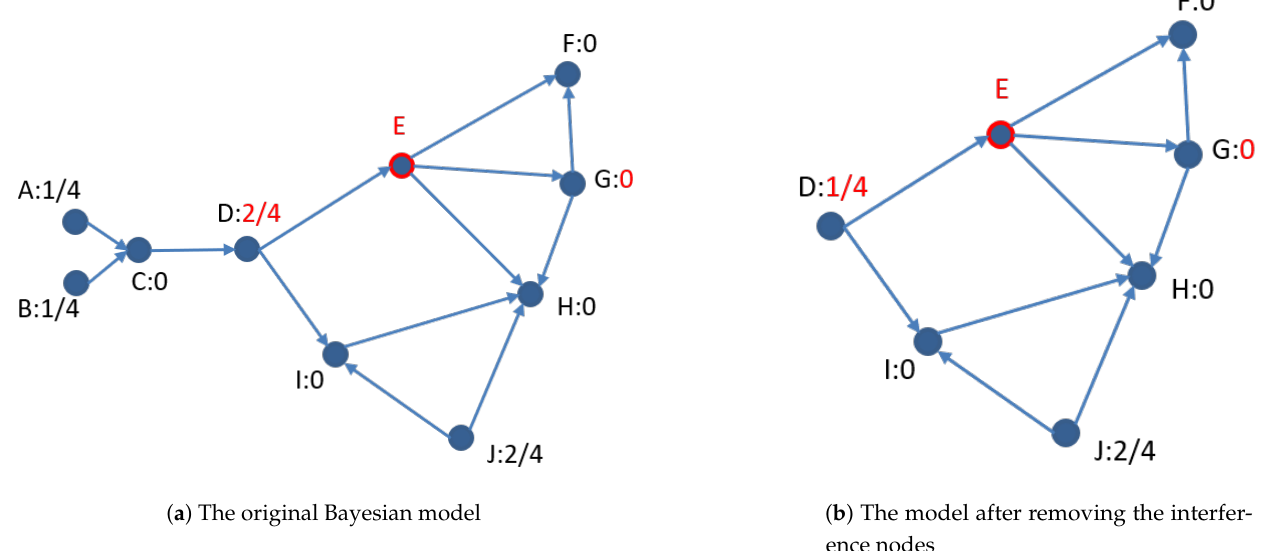
Figure 2. The loop-cutting contribution of each node after selecting node E as one loop cutset